Question: How would you classify this visualization?
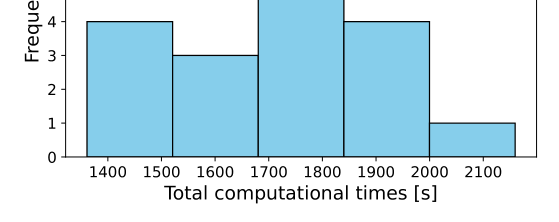
Answer: histogram